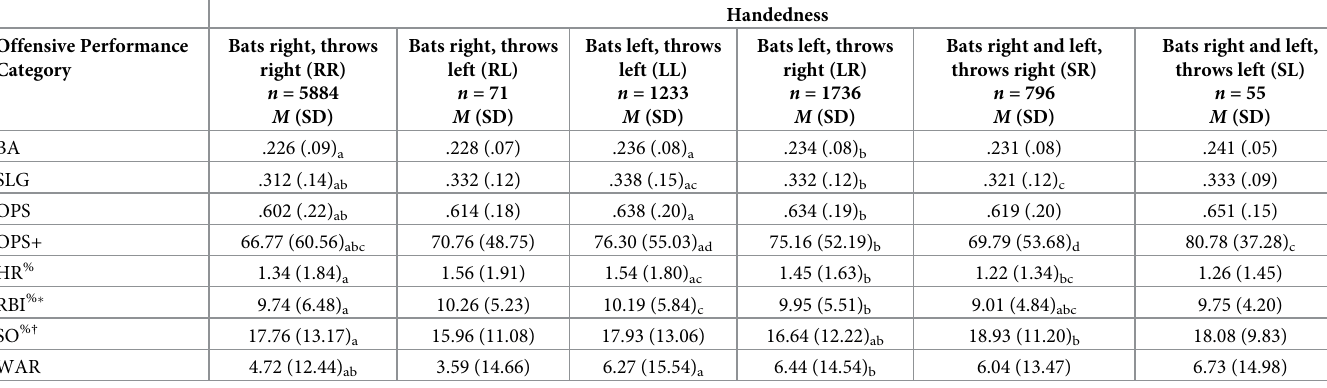
Table 1. Offensive performance values by handedness